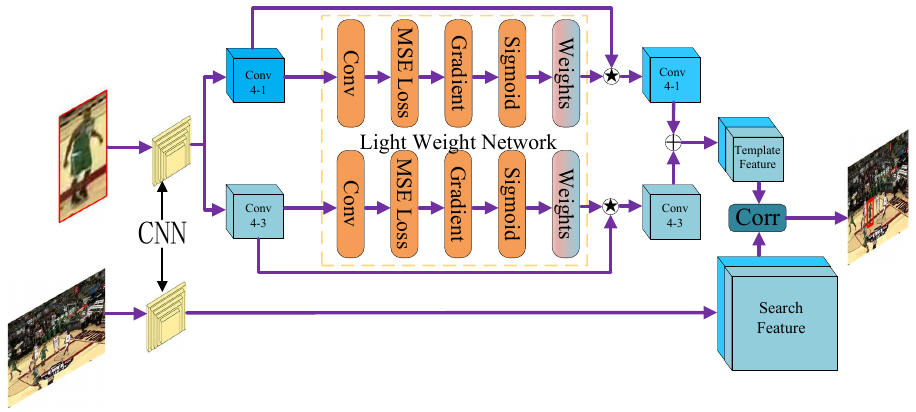
Figure 2. Overview of our network architecture for visual